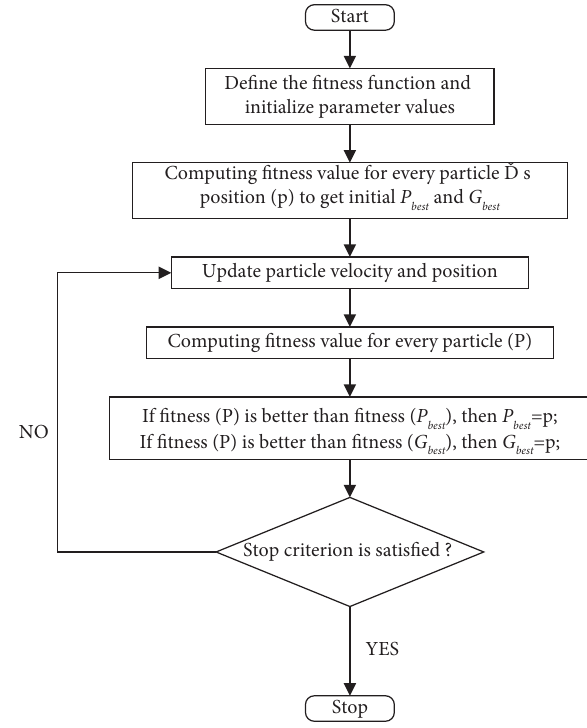
Figure 5: Flow chart of particle swarm